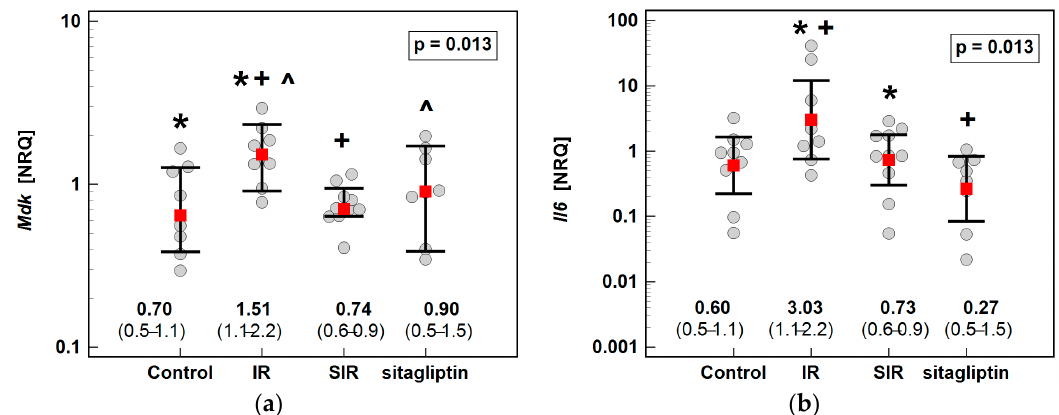
Figure 1. Effect of ischemia/reperfusion injury and sitagliptin on hepatic NADPH oxidase (Nox) expression: ( a ) Nox1 ; ( b ) Nox2 ; ( c ) Nox4 . Data are presented as geometric means ( Nox1 and Nox2 ) or medians ( Nox4 ) with 95% confidence intervals and analyzed with, respectively, one-way ANOVA or Kruskal–Wallis H test. Significant ( p < 0.05) between-group differ- ences are marked by the same type of symbols: *, +, ^. IR, ischemia/reperfusion group; SIR, ischemia/reperfusion group pretreated with sitagliptin; NRQ, normalized relative quantity.